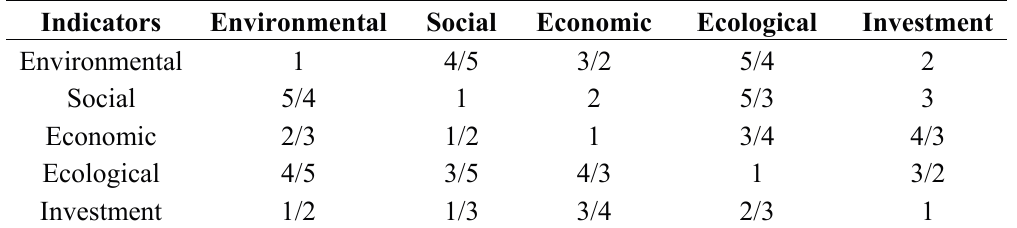
Table 10. Judgment optimization matrix for pairwise comparisons of the evaluation indicators.